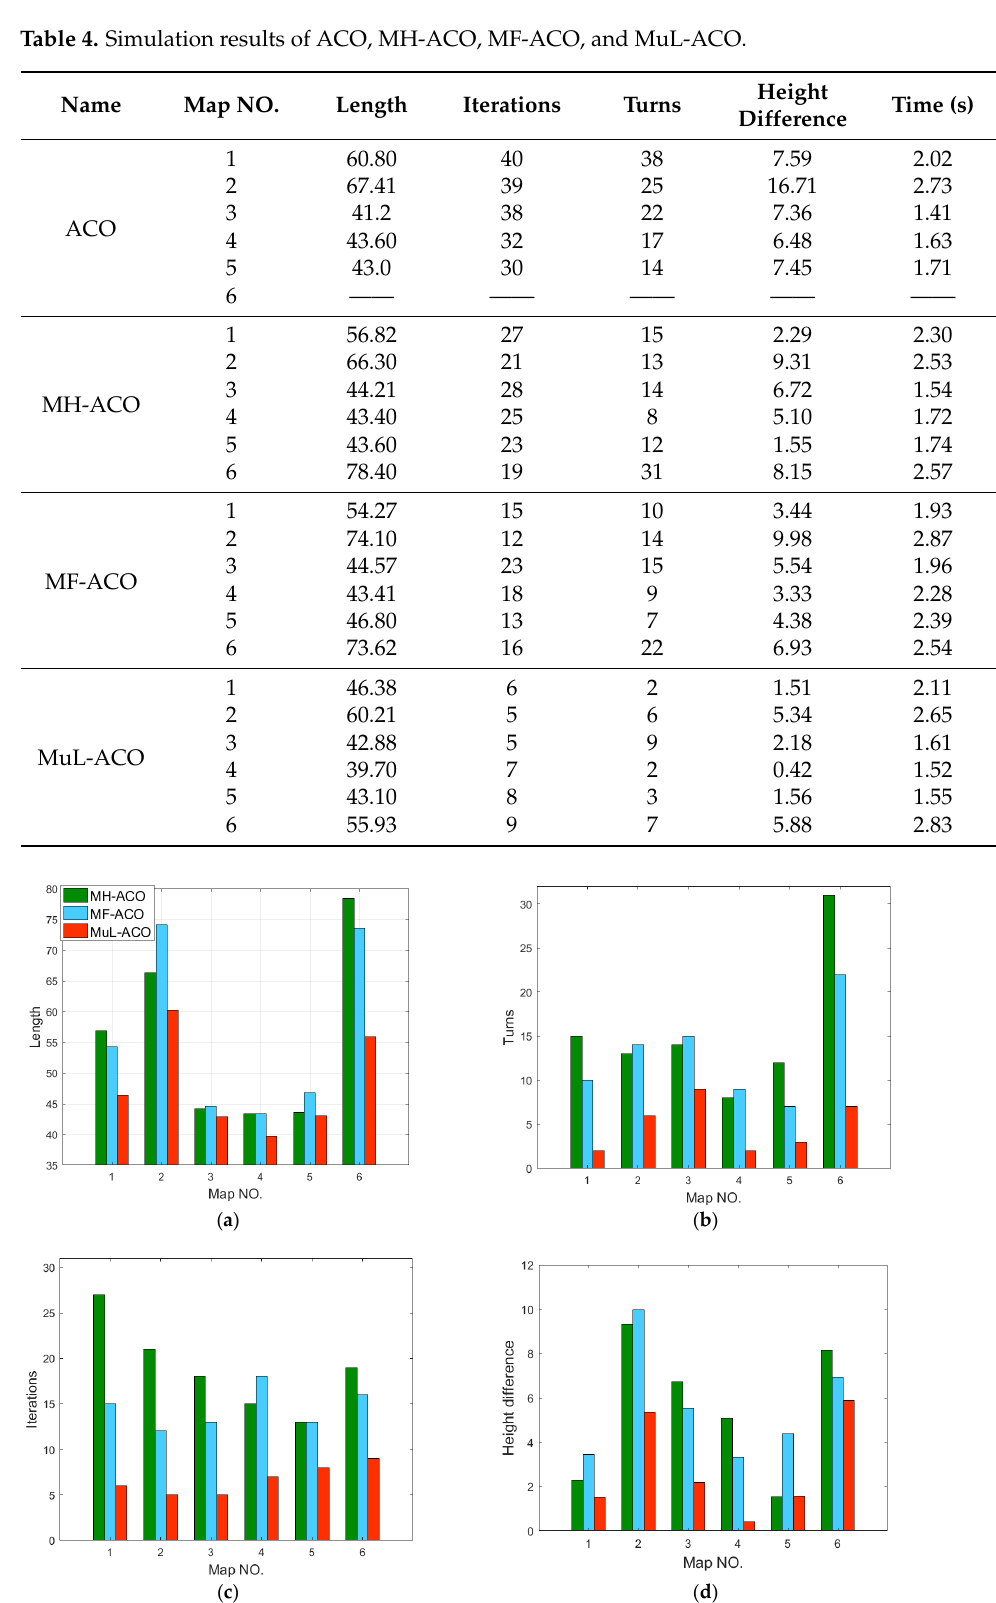
Figure 10. Comparison of trajectory performance. ( a ) length, ( b ) number of turns, ( c ) number of iterations, ( d ) the height difference of the trajectory.